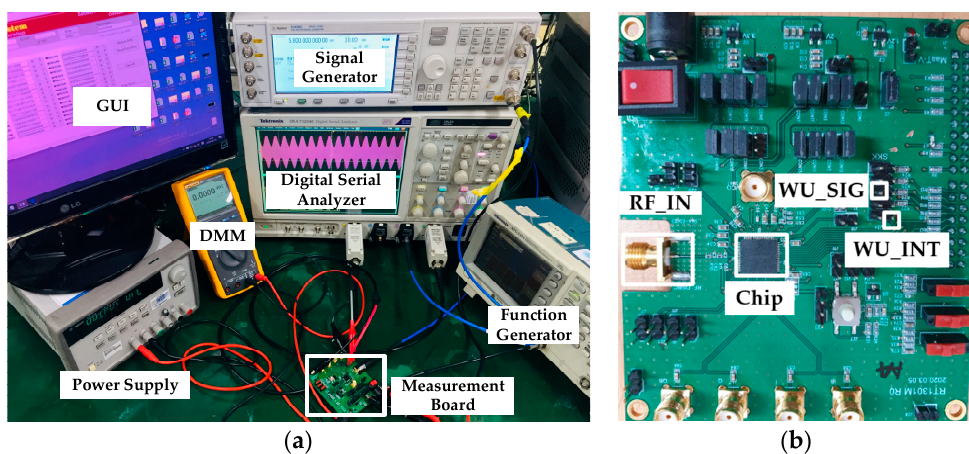
Figure 14. WuRx measurement: ( a ) experimental lab setup; ( b ) measurement board with chip.